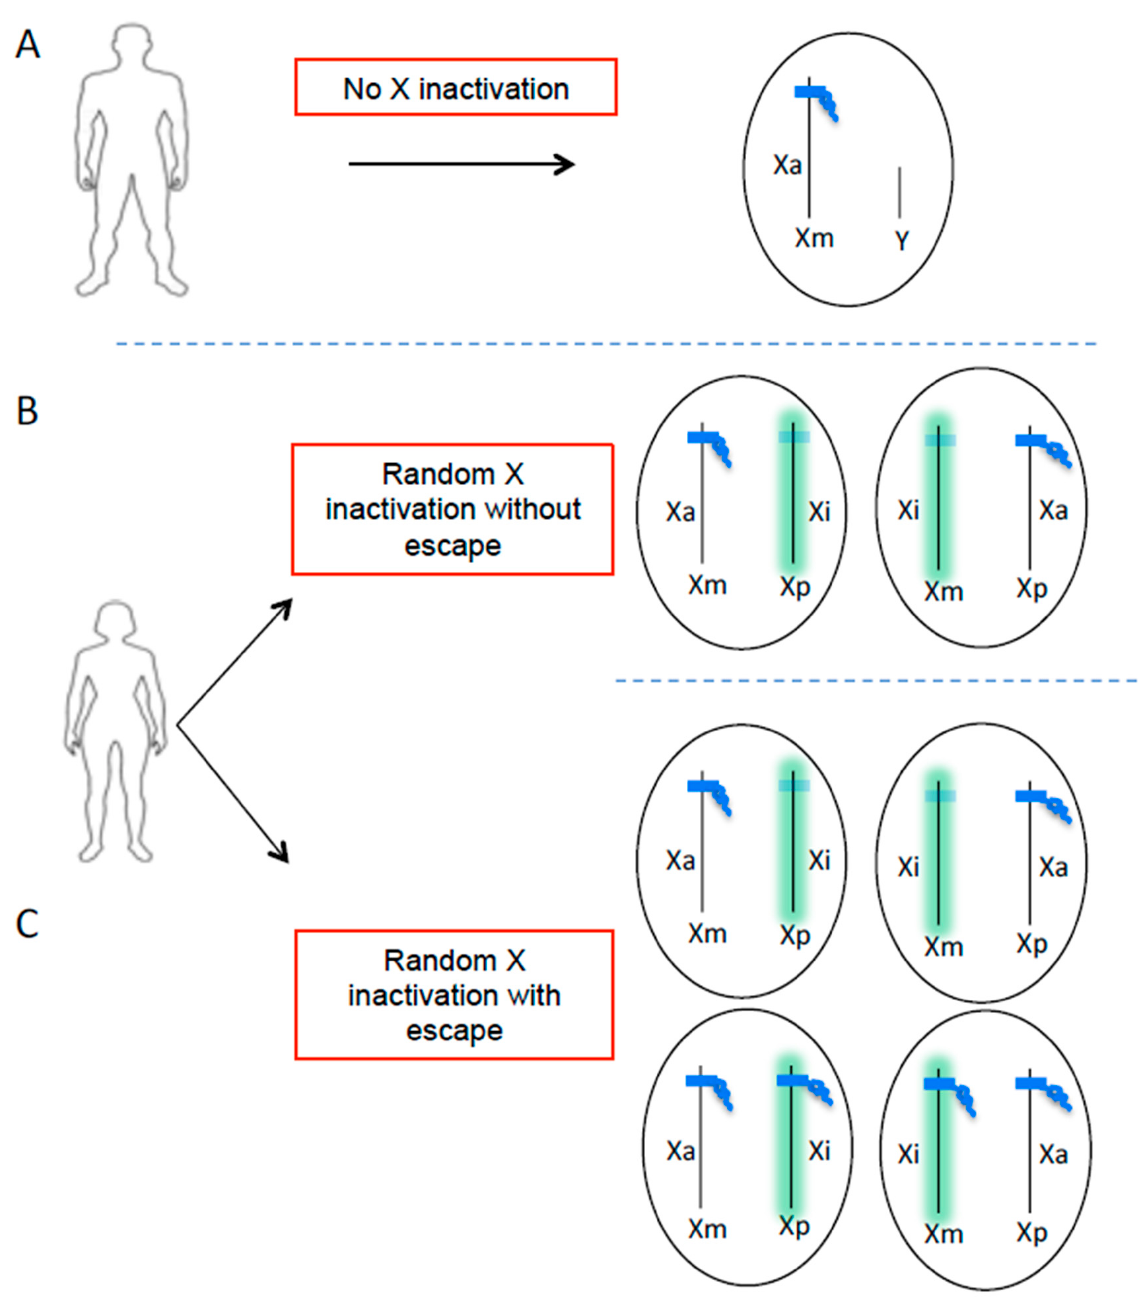
Figure 1. X chromosome inactivation escape generates additional cellular heterogeneity in the expression of X-linked genes in women. Men have only one active X chromosome ( A ) and women have two X chromosomes inherited from each parent (maternal X = Xm, paternal X = Xp). In order to balance the dosage of genes carried by the X chromosome between males and females, one of the two chromosomes X is randomly inactivated during embryonic development in women ( B , C ). This process is initiated by the long non-coding RNA XIST (green), which becomes highly expressed on one allele and coats the future inactive X chromosome (Xi) in cis , leading to transcriptional repression. The result is a cell mosaic where in theory half of the cells have an active chromosome (Xa) of maternal origin and the other half of paternal origin ( B ). However, certain genes can escape XCI, including TLR7 , generating additional cellular heterogeneity in the expression of X-linked genes ( C